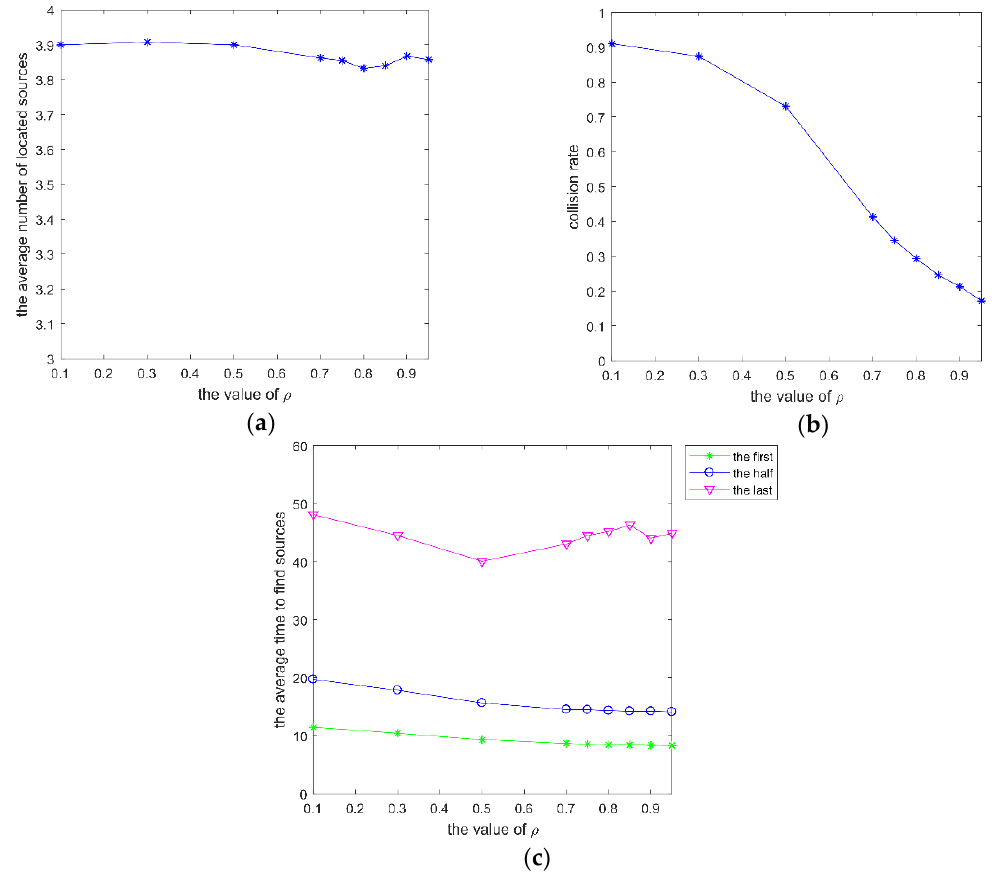
Figure 6. mI of SRPB at di ff erent ρ , which varies within (0.1, 0.95). ( a ) the average number of located sources; ( b ) collision rate; ( c ) average time to find different sources.